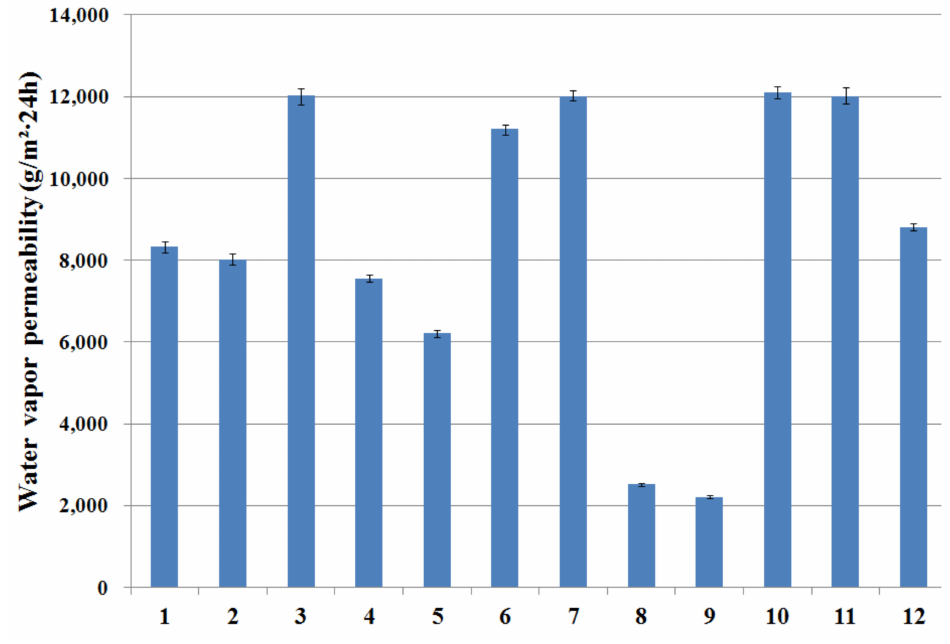
Figure 3. Water vapor permeability of 12 fabric